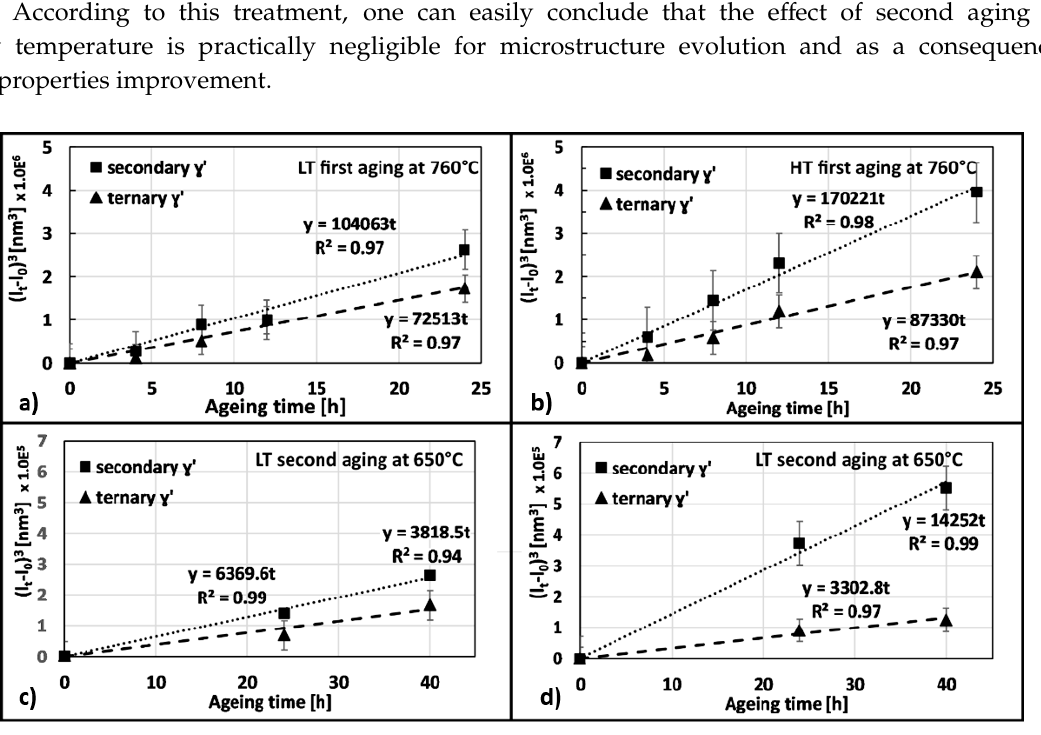
Figure 15. Plot of the cubic difference between the side length at a certain aging time and the side length of ɣ ’ just after solutioning treatment. a ) first aging on LT, b ) first aging in HT, c ) second aging in LT and d ) second aging in HT.